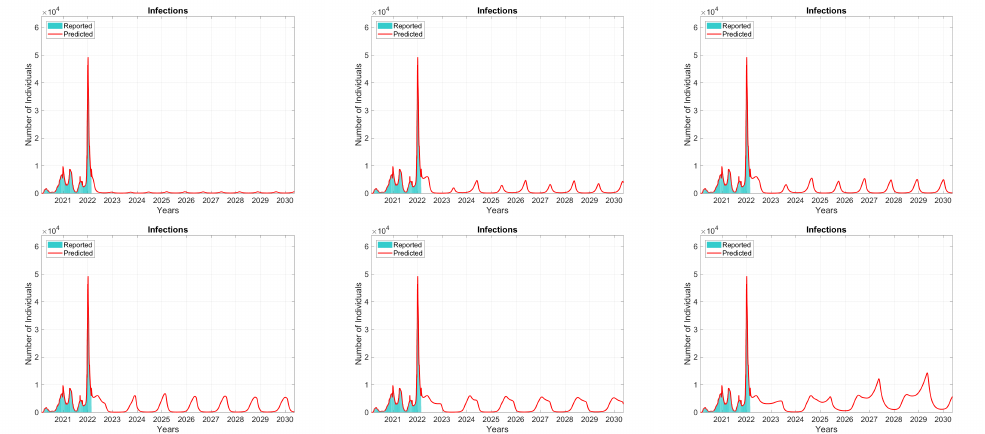
Figure 6. Predictions of daily infections in Canada considering periodic vaccination booster cam- paigns with periods of 270, 360, 390, 450, 540, and 720 days.